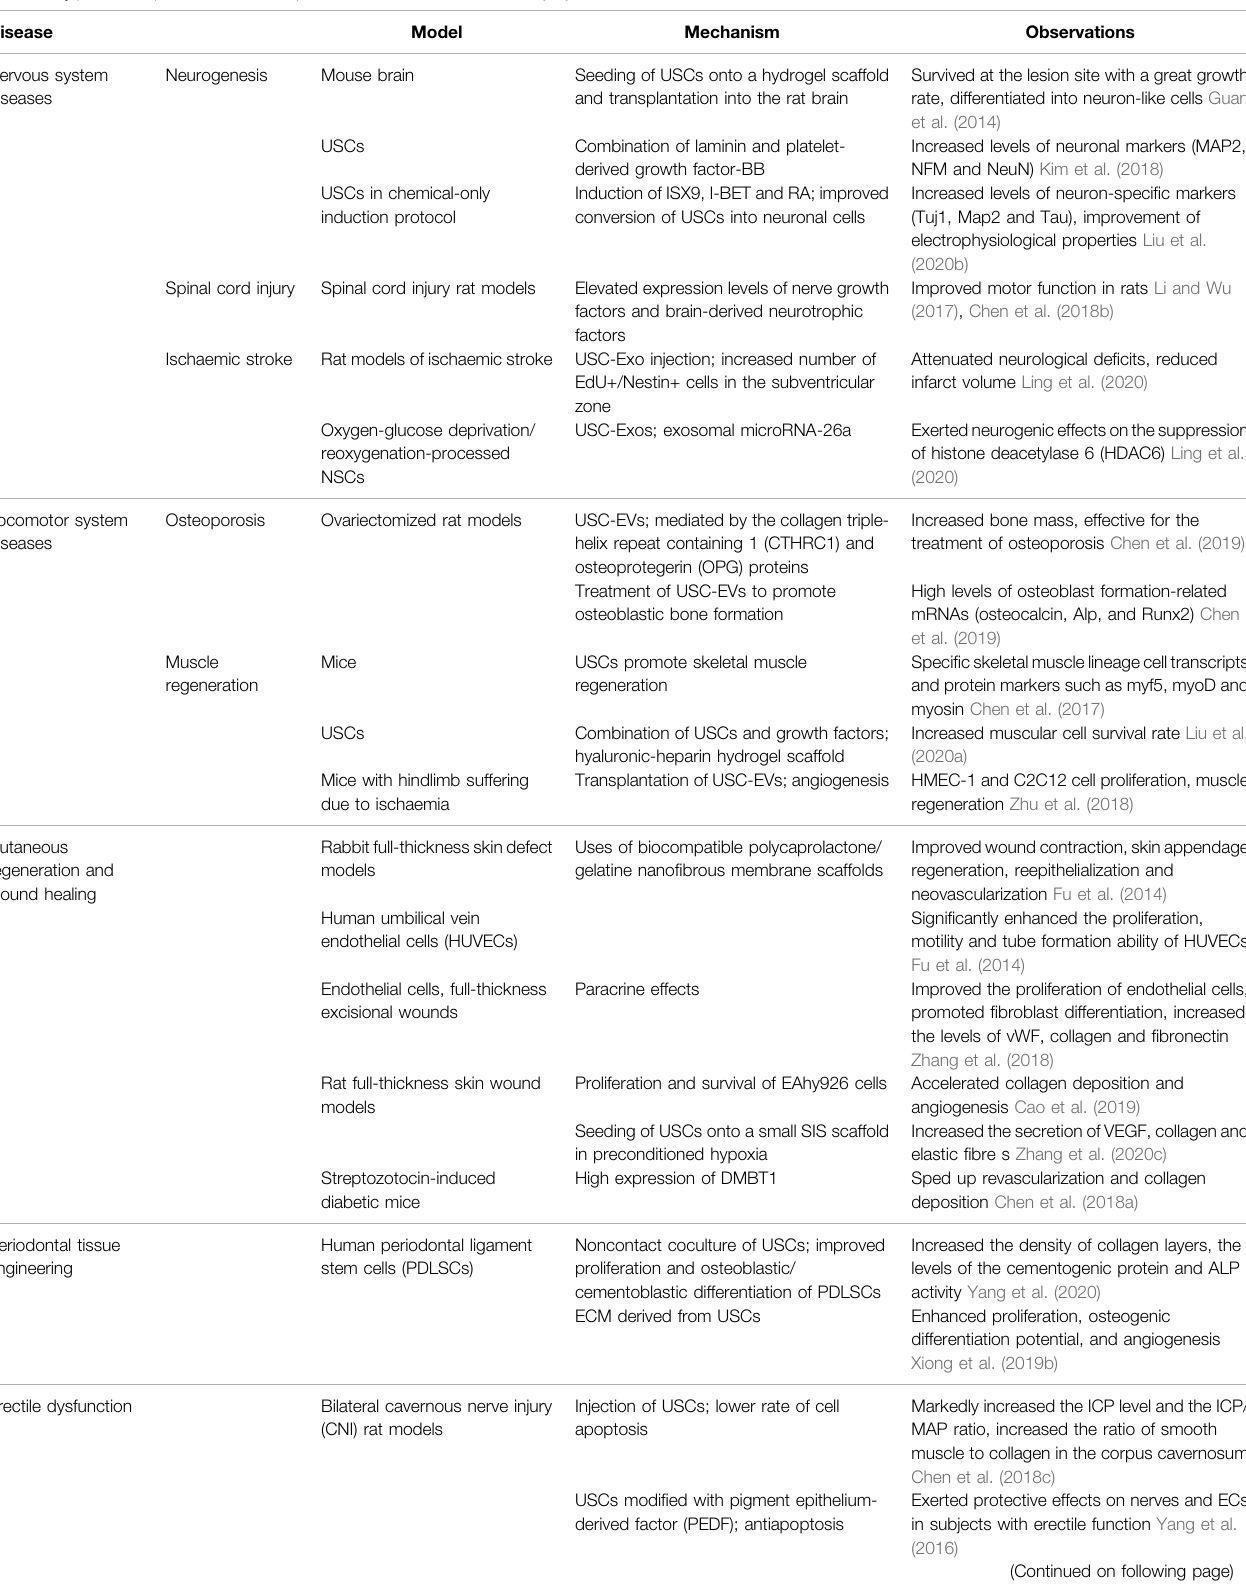
TABLE 1 | ( Continued ) USC-based therapies for various diseases of bodily